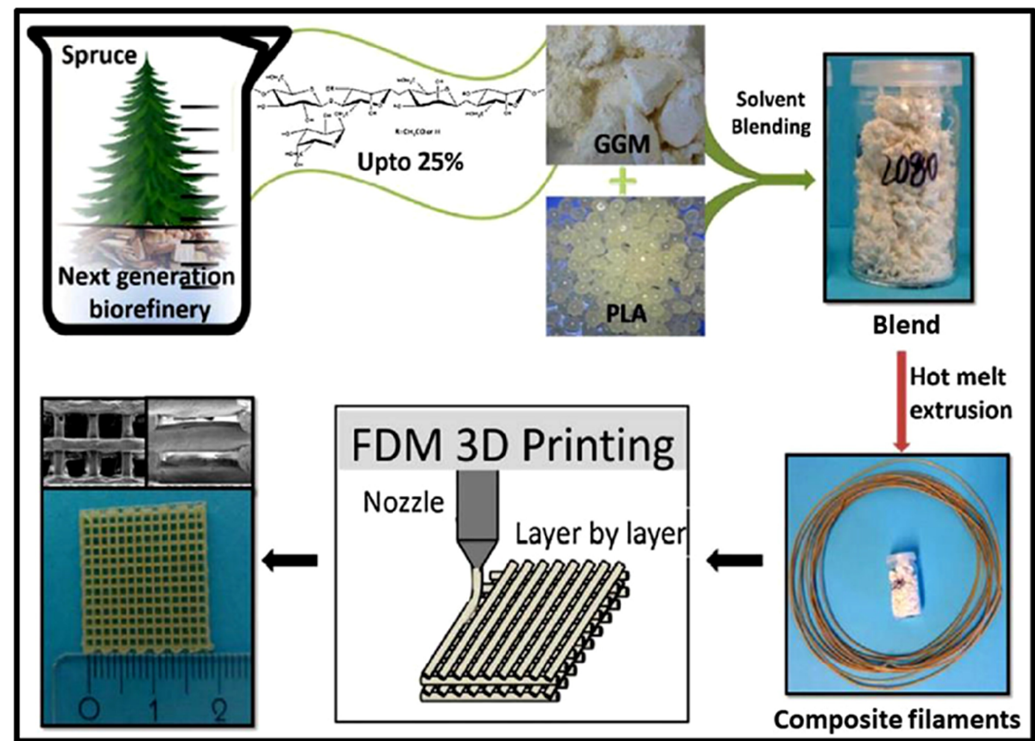
Figure 4. Preparation of 3D printed scaffolds using fused deposition method (FDM) from galactomannan/PLA composite filaments. Reprinted with permission from ref. [43]. Copyright 2018 Elsevier.